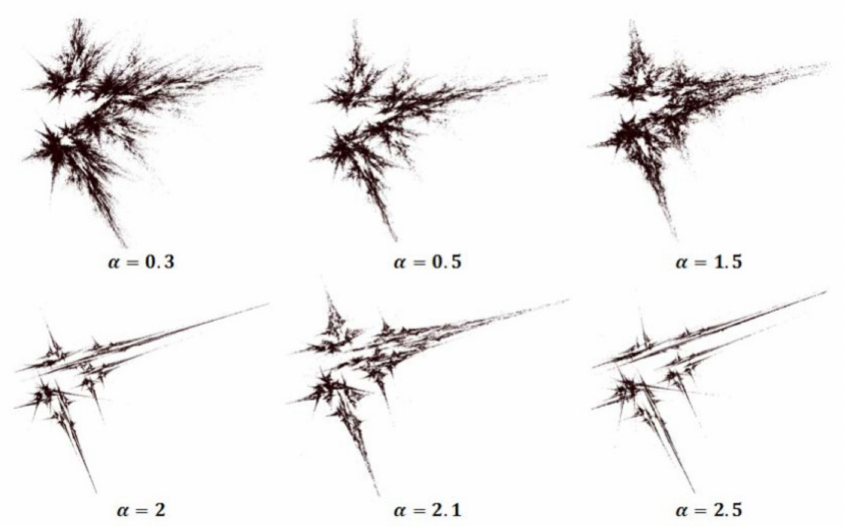
Figure 6. Some last images of fractals of the third kind of the neural network with different growth